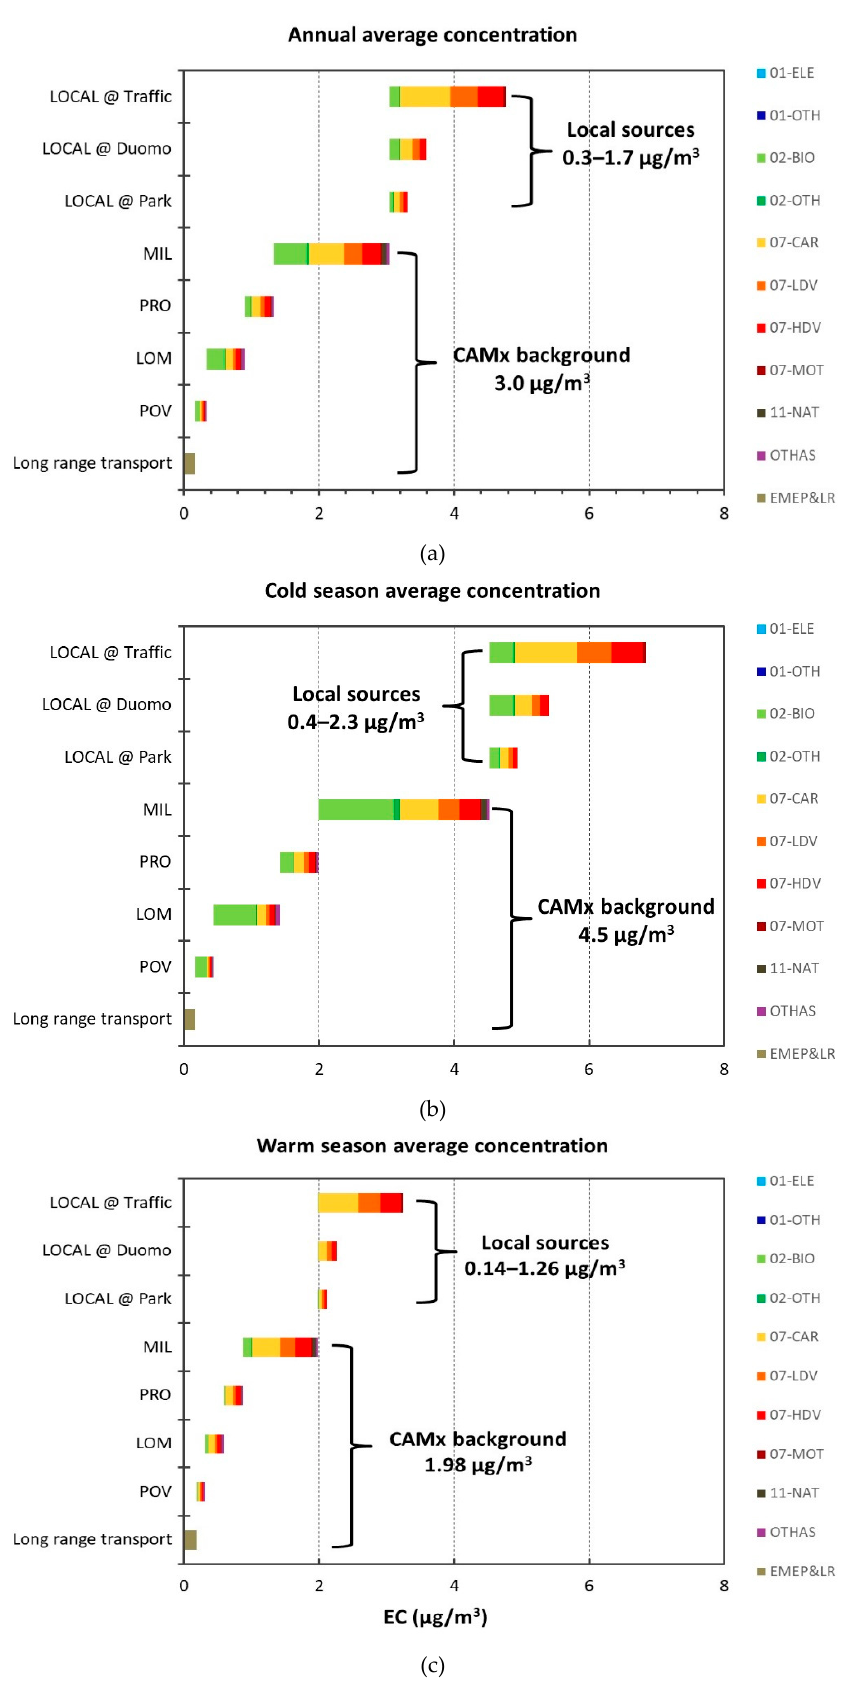
Figure 9. EC source apportionment by HMS for PARK, DUOMO and TRAFFIC receptors for annual average ( a ), cold season average ( b ), warm season average concentration ( c ).